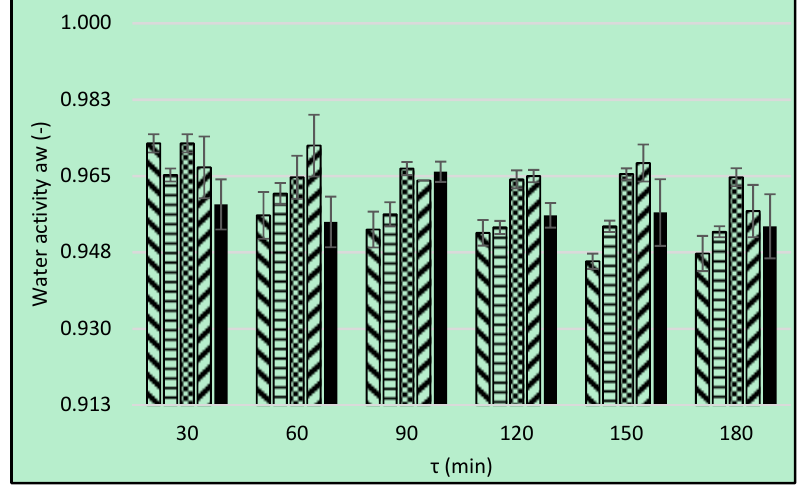
Figure 6. Water activity, a w , bars present the use of different solutions: erythritol ( ), xylitol ( ), maltitol ( ), dihydroxyacetone ( ), sucrose ( ). Dotted line is an initial a w of raw apple tissue. Table 11. The influence of osmotic agents and pre-treatment time on water activity during OD. Factor p -Value